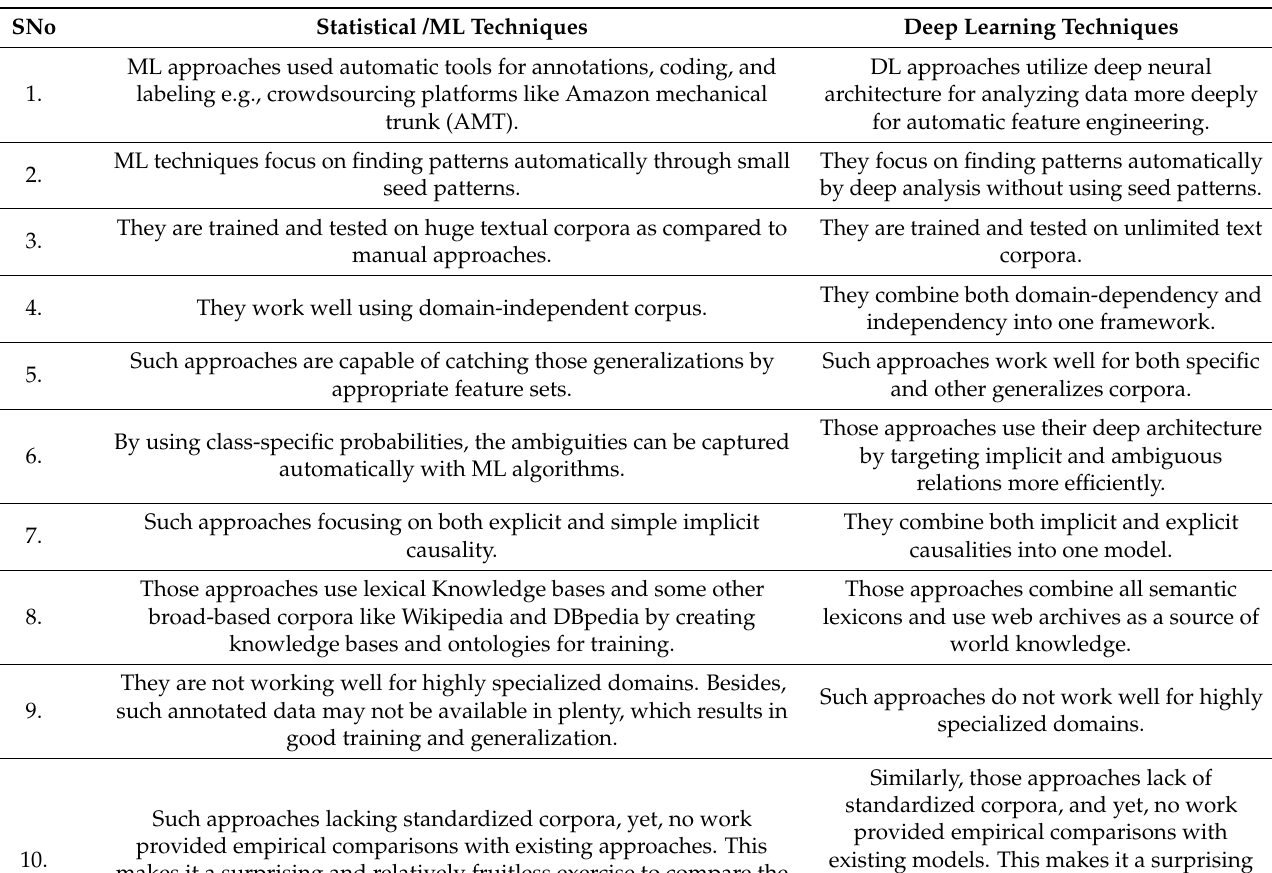
Table 6. Comparison among mentioned